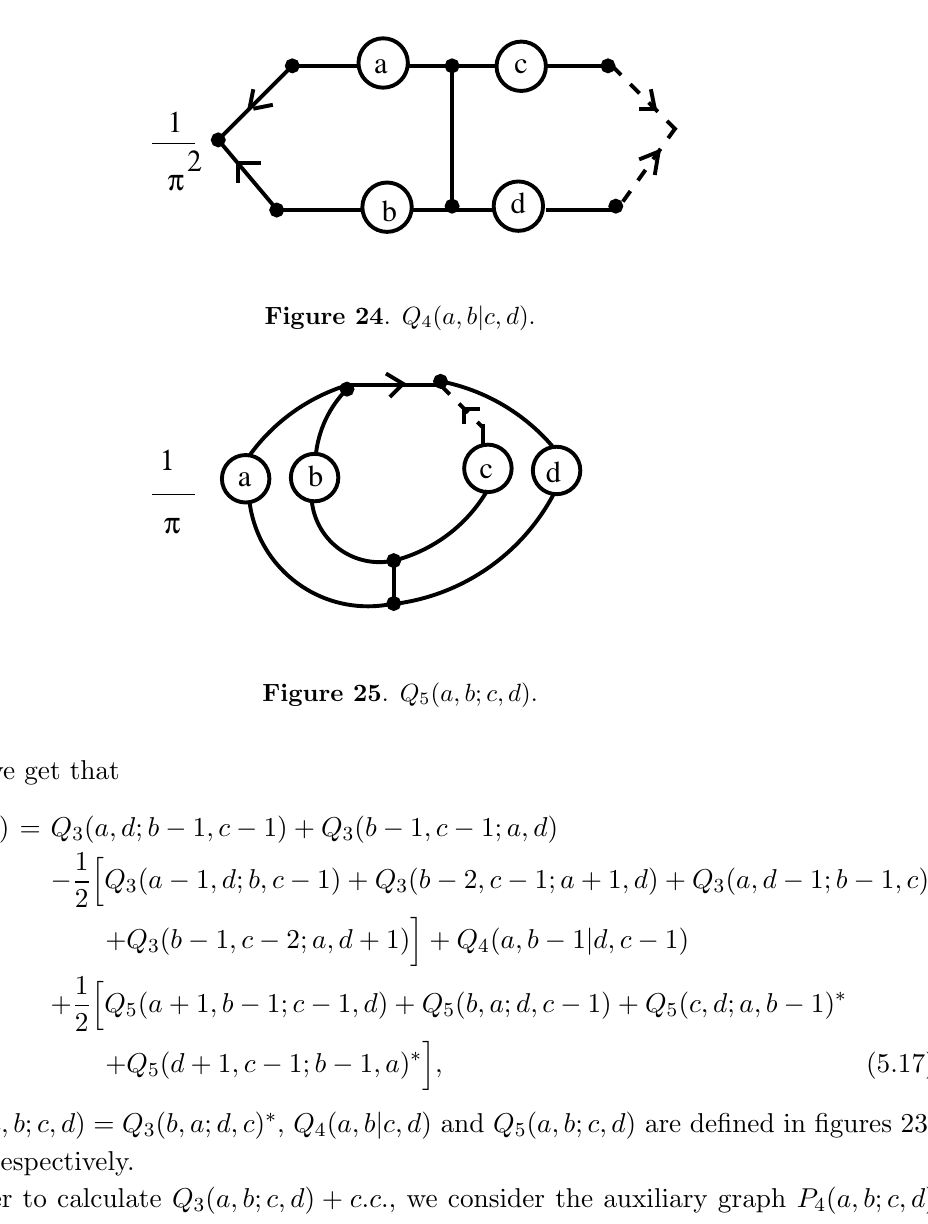
Figure 24 . Q 4 ( a; b j c; d ).